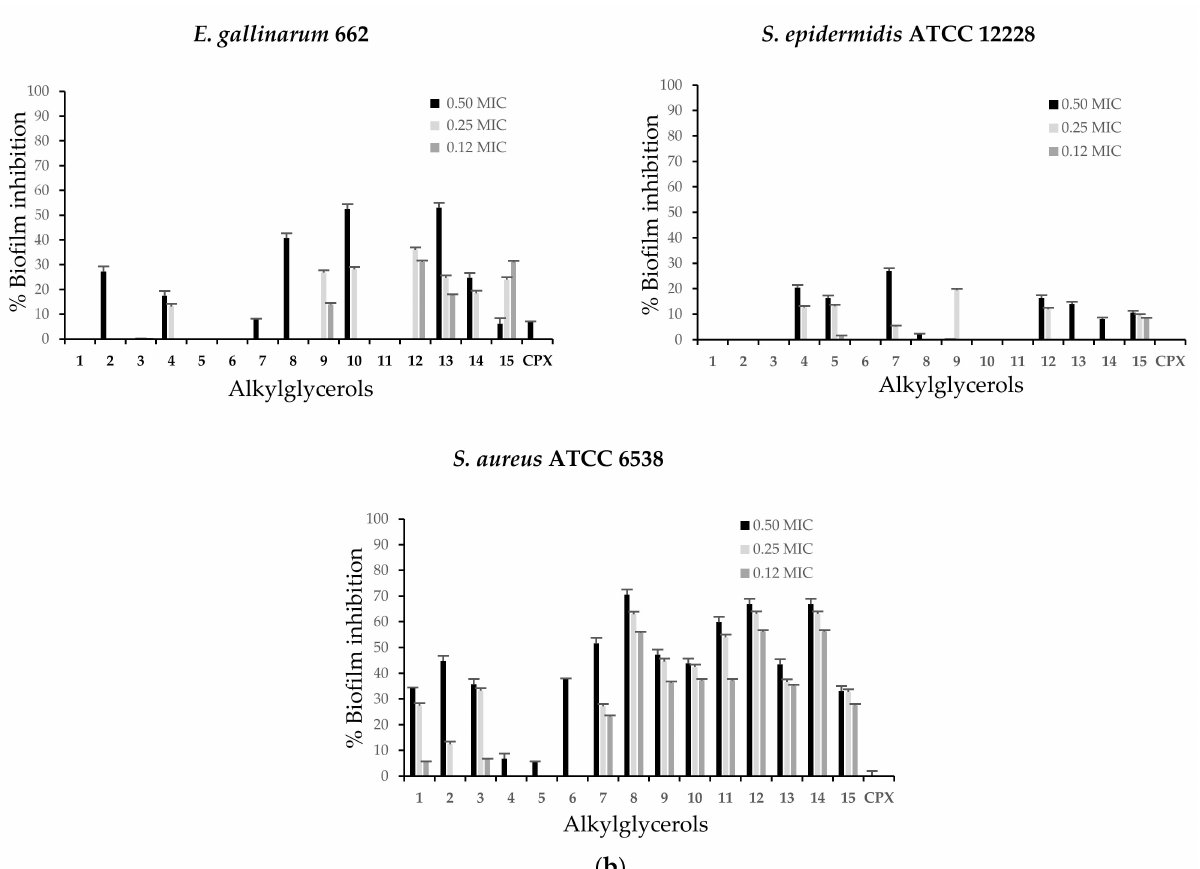
Figure 2. ( a ) Biofilm inhibition represented as percentages of enantiopure alkylglycerols against clinical bacterial isolates: K. pneumoniae 792, E. cloacae 250, E. coli 667 and P. aeruginosa 740 at different subinhibitory concentrations. ( b ) Biofilm inhibition represented as percentages of enantiopure alkylglycerols against clinical bacterial isolates: P. mirabilis 26, E. faecalis 12, E. gallinarum 662 and reference strains S. epidermidis ATCC 12228 and S. aureus ATCC 6538 at different subinhibitory concentrations. CPX was subject to the same assays. The results are expressed as the mean of three independent experiments and error bars represent the standard deviation. Biofilm formation was significantly reduced compared to untreated control biofilms of each of these bacteria at the tested concentrations of the